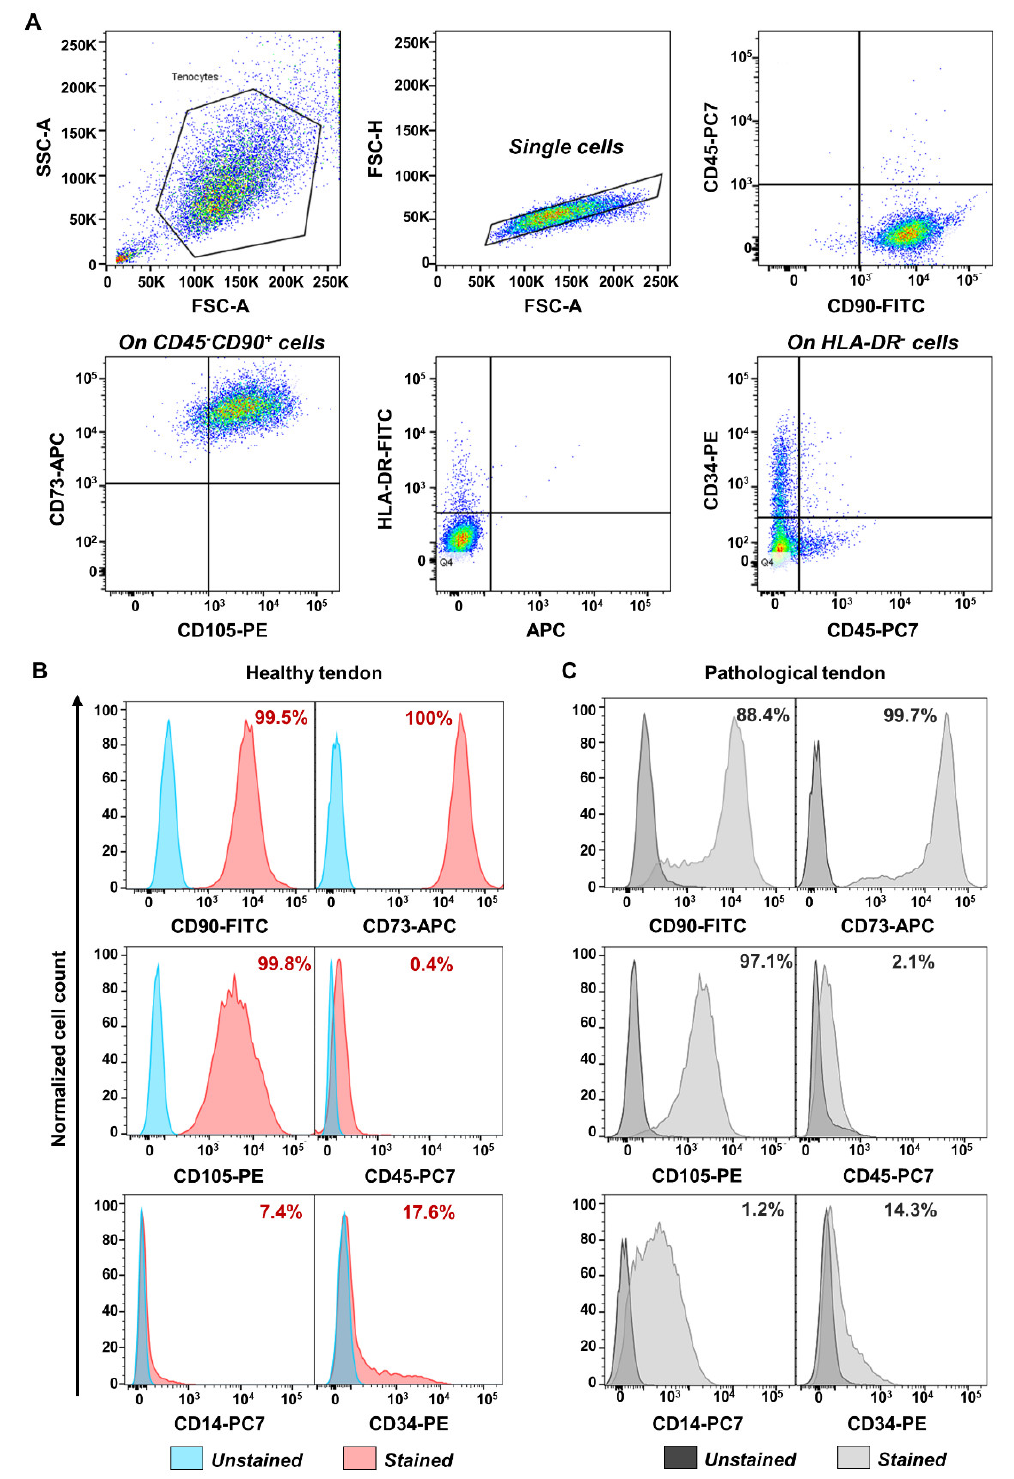
Figure 1. Flow cytometry characterization of tendon stem/progenitor cells (TSPCs) extracted from healthy and pathological tendon samples. ( A ) The panel shows representative flow cytometry events on forward scatter (FSC) vs. side scatter (SSC), excluding double cells (FSC-A vs. FSC-H) and further studying CD45, CD90, CD73, CD105, HLA-DR, CD34, and CD14 surface marker expression. Normalized cell count histograms display marker expression on single cells in ( B ) healthy and ( C ) pathological tendon.